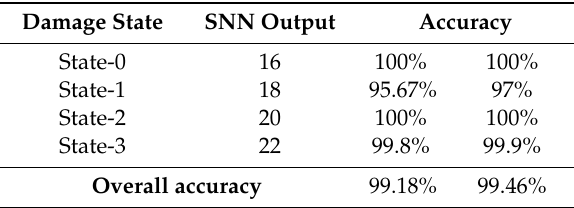
Table 7. Accuracy of each class.